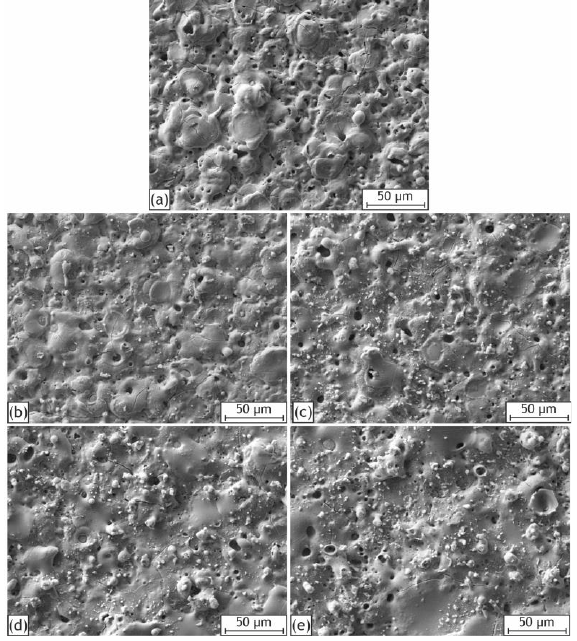
Figure 1. SEM images of the coatings surfaces: H0 ( a ), H10 ( b ), H20 ( c ), H30 ( d ), H40 ( e ).